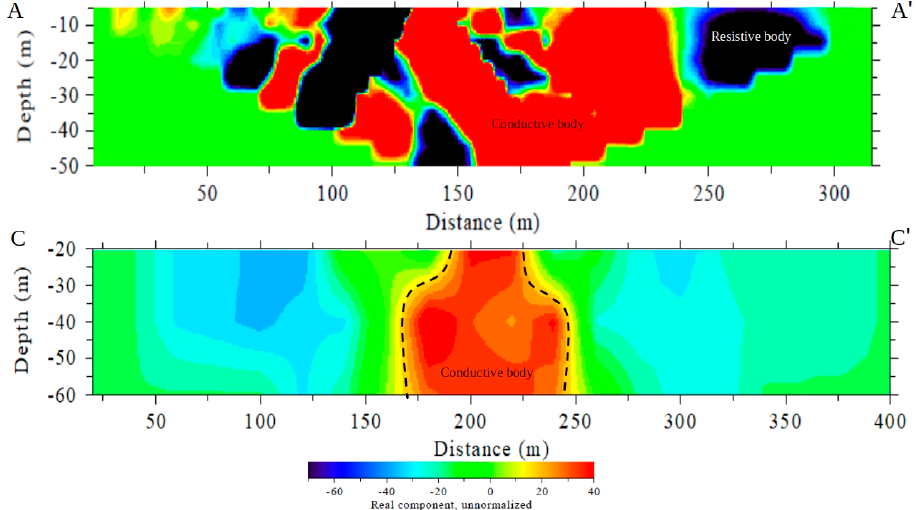
Figure 14. VLF-EM results along the A-A’ (station spacing 5 m) and C - C’ (station spacing 20 m) survey lines. These cross-sections show high resistive zones as a possible presence of a cave and sediment-filled doline. Red color represents conductive (hot) targets.